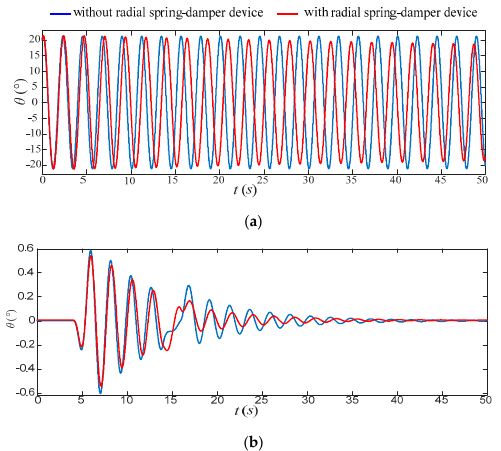
Figure 3. Simulation 1: Pendulum angle response curve. ( a ) Pendulum angle response curve under the same initial pendulum angle disturbance; ( b ) Pendulum angle response curve under the same driving force. Simulation 2: Controller comparison experiment. The control performance of the proposed control method is compared with PID and CSMC [29] methods in the same sim- ulation environment. The PID and CSMC control laws are as follows.